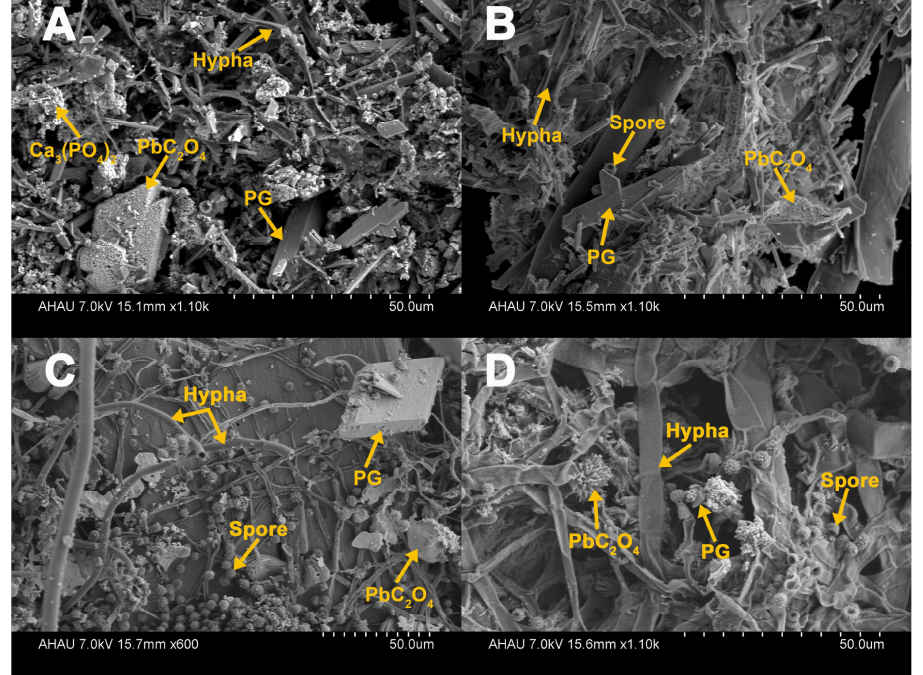
Figure 8. SEM image and EDS point data for ANG + PG ( A ), ANG + NH 4+ + PG ( B ), ANG + NO 3- + PG ( C ), and ANG + urea + PG ( D ) treatments after six days of incubation.